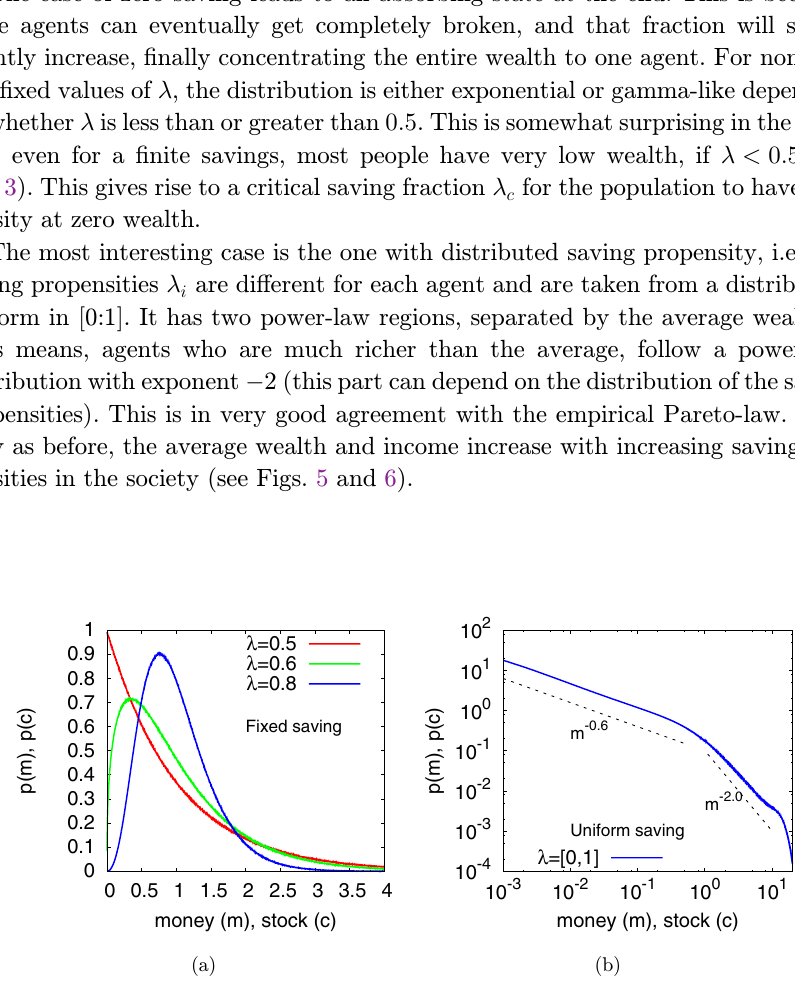
Fig. 2. The distribution of wealth (stock or money) among the agents, (a) when the saving propensity (cid:1) has constant values and (b) when (cid:1) i are uniformly distributed in